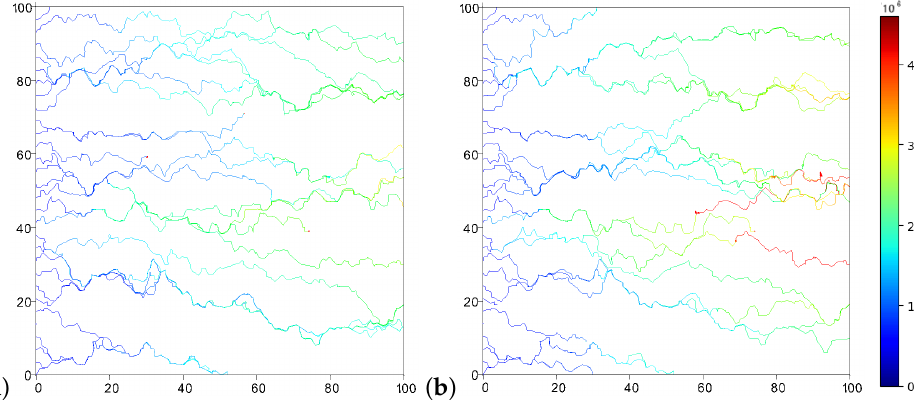
Figure 3. Streamlines of the fluid flow under 200 m depth with 0.5 in situ ratios in the 100 m by 100 m block of coal. The fully saturated conditions ( a ) have a lower retention time (shown in seconds) compared to the unsaturated conditions ( b ).